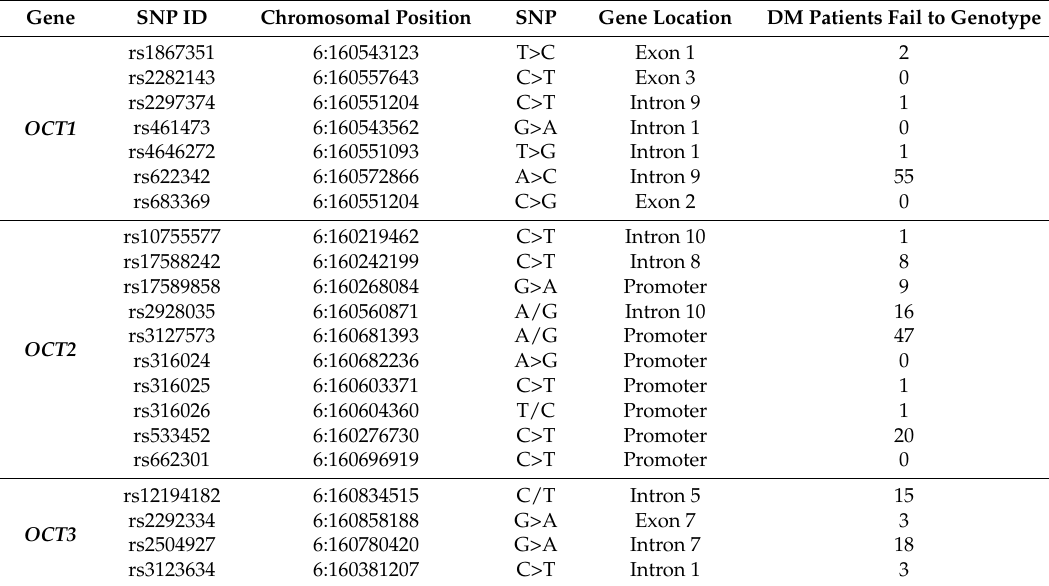
Table 1. List of studied SNPs, chromosomal positions, gene locations based on the National Center for Biotechnology Information (NCBI) Human Genome Assembly Build 36.3 and diabetes mellitus (DM) patients fail to